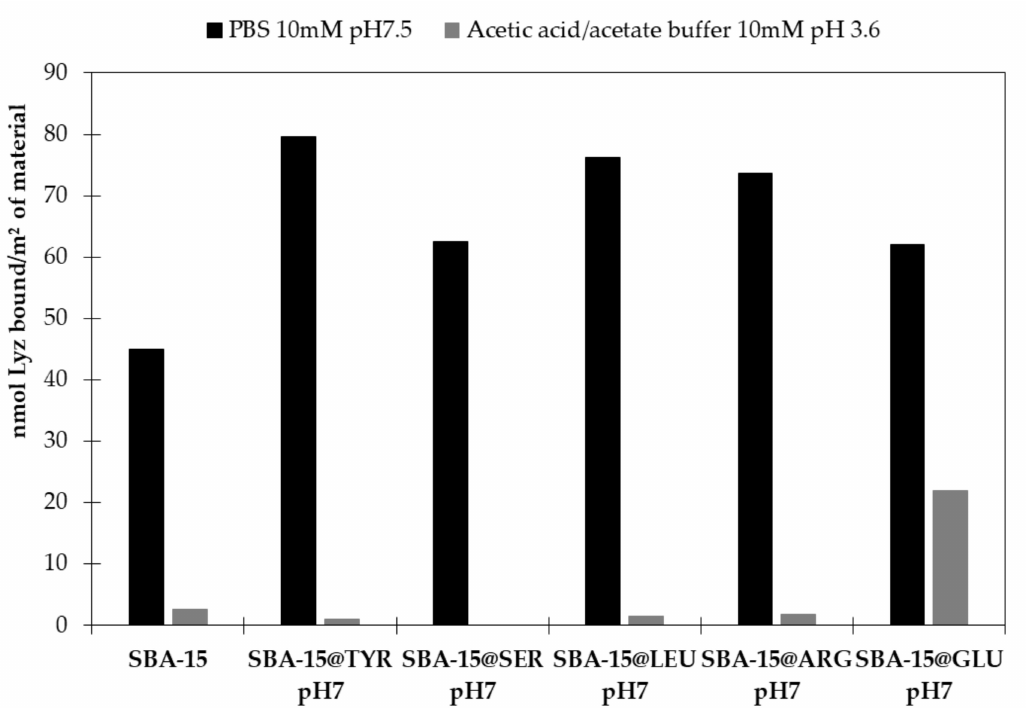
Figure 13. Amount of Lysozyme bound per m 2 of material at physiological conditions, i.e., PBS 10 mM pH 7.5 ( black ) and under acid conditions, i.e., acetic acid/acetate 10 mM pH 3.6 ( grey ). (See Section 3.4 for